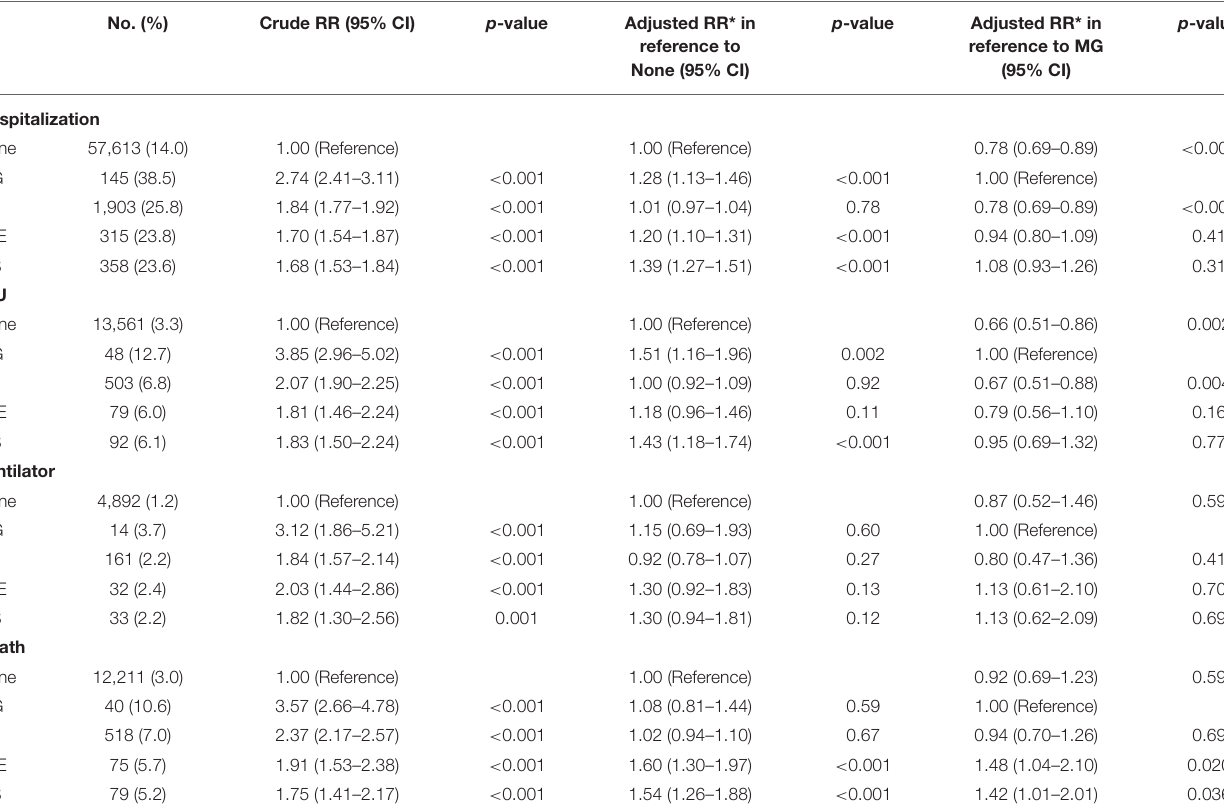
TABLE 2 | The comparisons of COVID-19